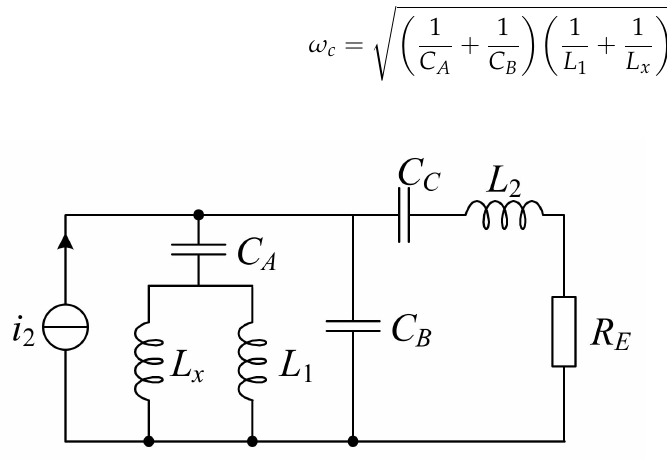
Figure 8. The simplified L x -PS CPT circuit using the T-type model to realize constant current (CC